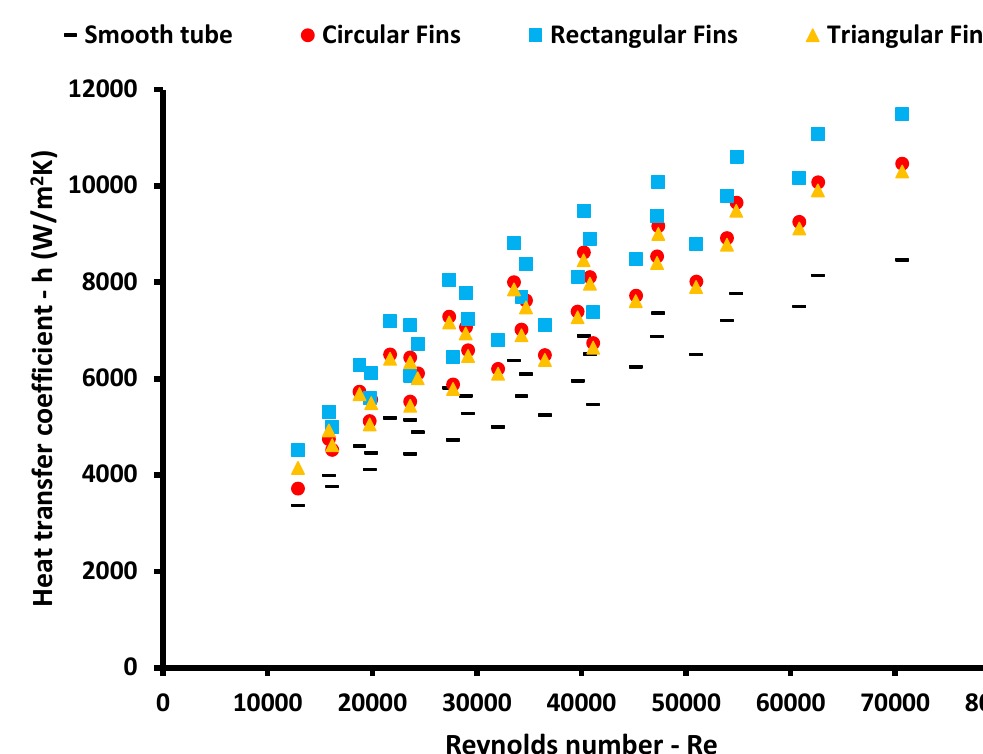
Figure 15. Heat transfer coefficient in the examined cases for all the tubes.